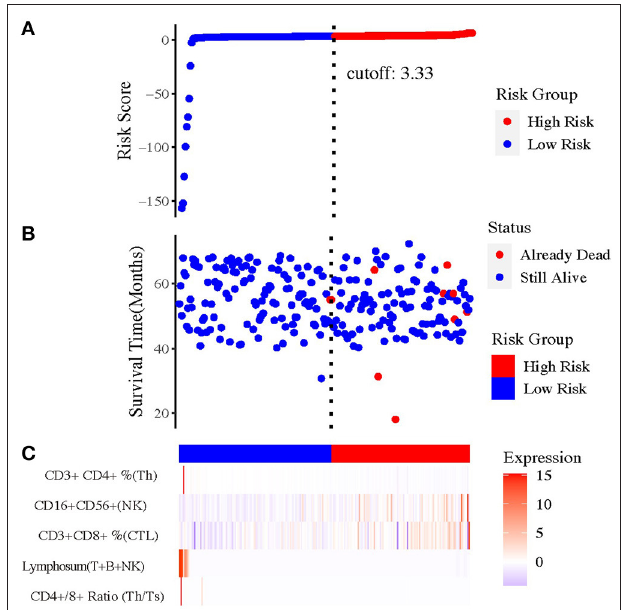
FIGURE 2 | The prognostic value of risk model of the five immune-related indexes. (A) The risk curve based on the model with the largest area under curve (AUC). (B) The scatterplot based on the survival status of each sample. The blue and red plots represent low risk and high risk, respectively. (C) The heatmap showed the enrichment level of immune-related indexes in peripheral blood in high- and low-risk